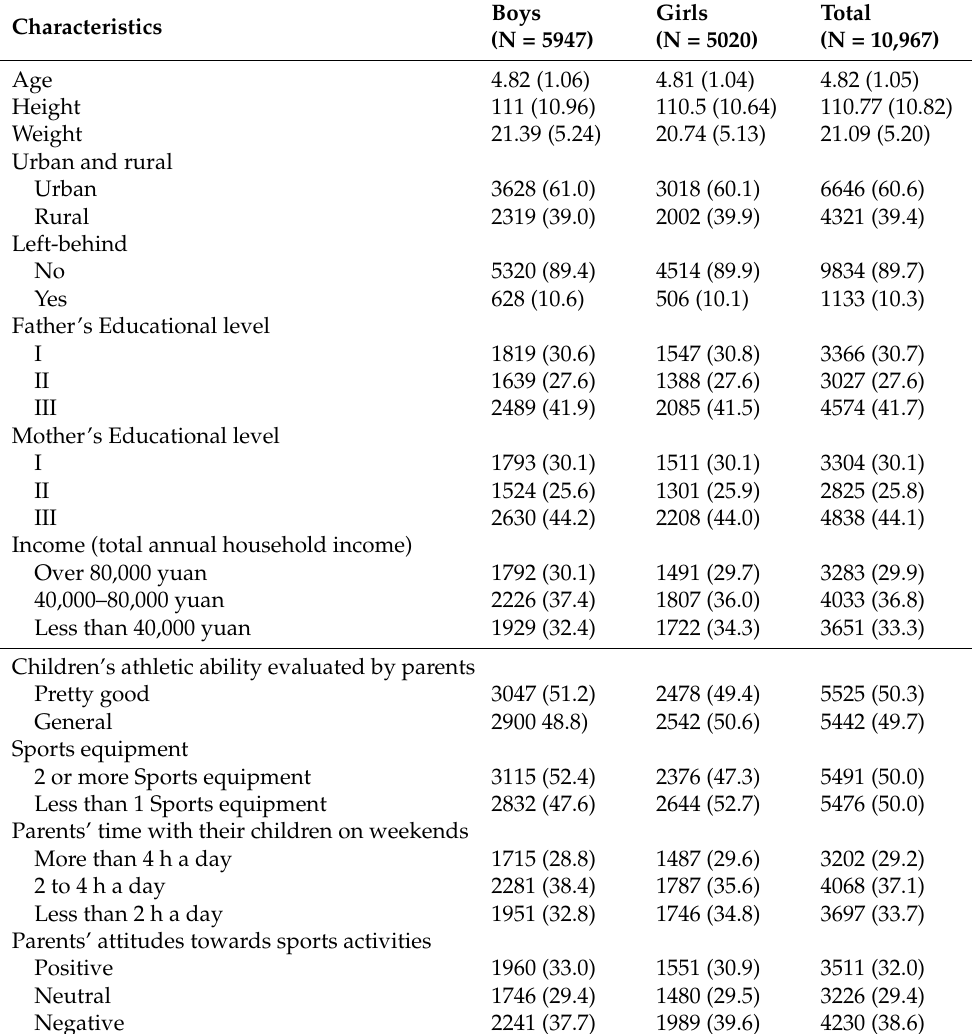
Table 1. Demographic information of the participants; mean (SD) or number